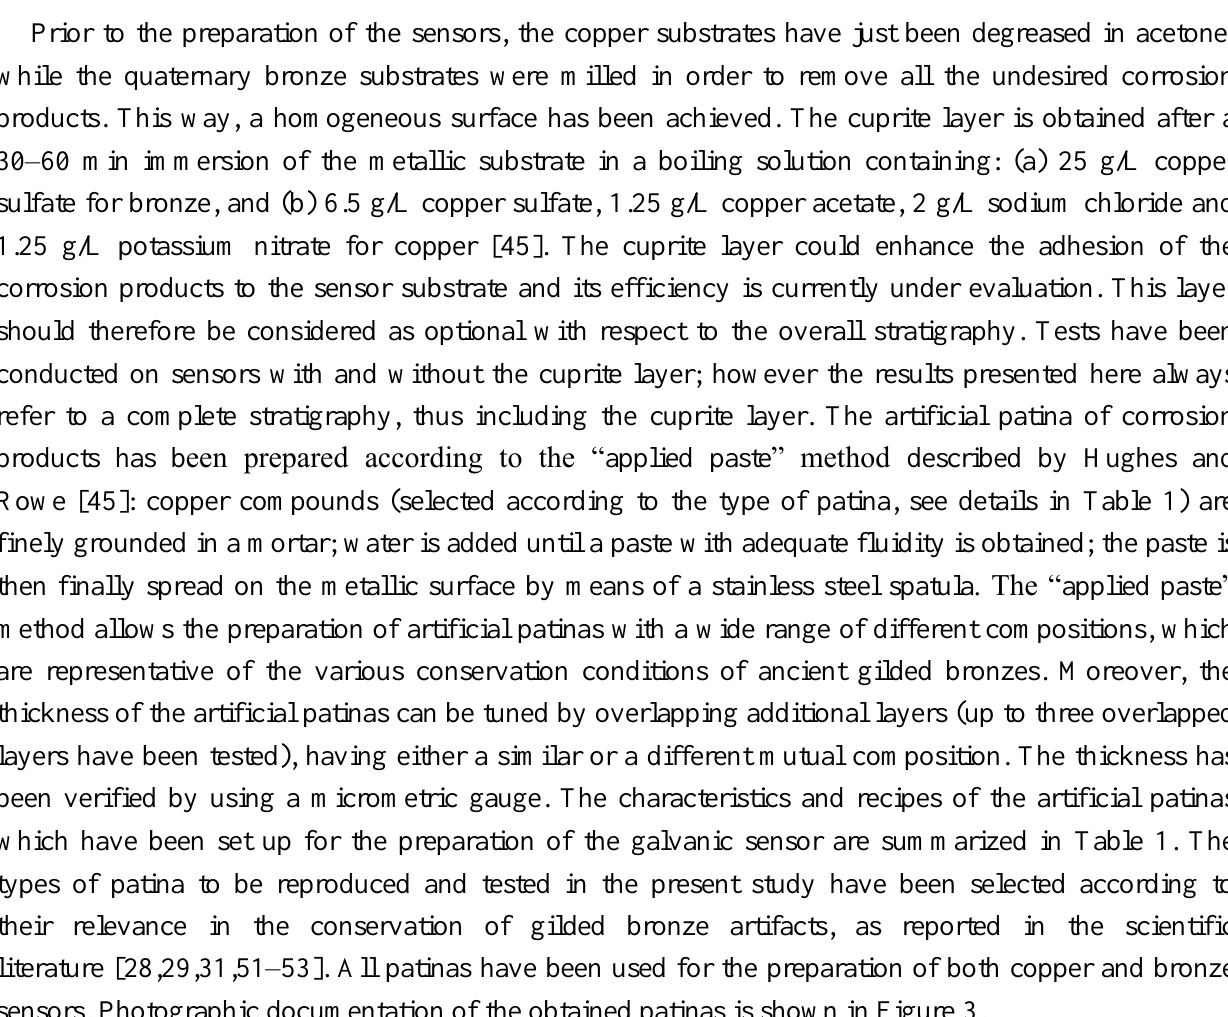
Figure 3. Photographic documentation of the different types of patina: S&C ( A ); BCC ( B